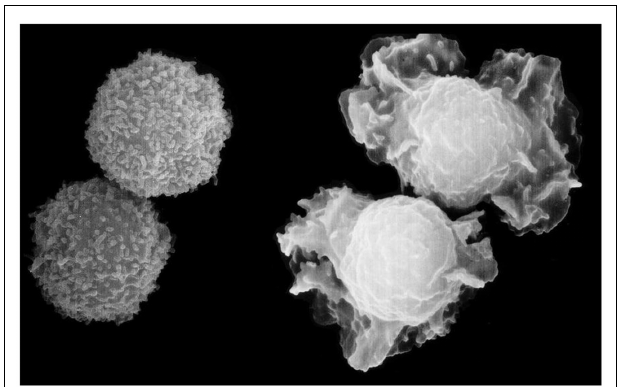
FIGURE 1 | Shape change of neutrophils, the most elegant response to chemo-attractants, observed within seconds of challenge, and characterized by the protrusion and retraction of ectoplasmic extensions, due to polymerization and breakdown of actin . The protrusions appear to function like a swimmer’s arms and legs. Turbidity recordings suggest that the changes are synchronized, possibly to facilitate migration (11). Scanning electron micrograph by Matthias Wyman , a former Ph.D. student at TKI, now professor at the University of